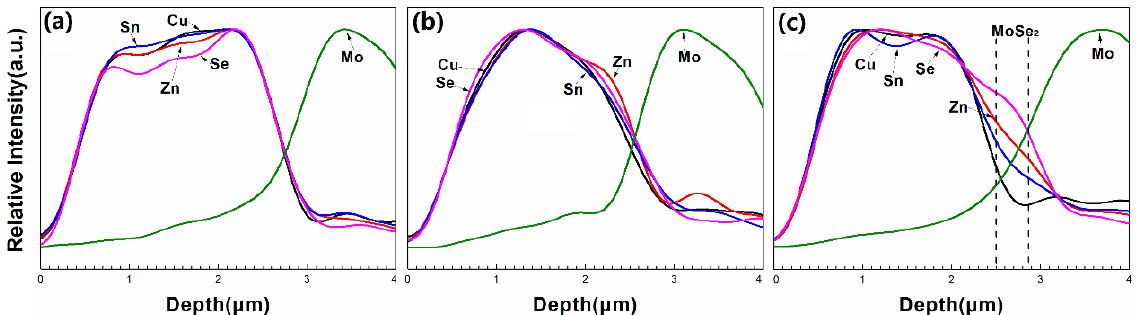
Figure 8. The line scanning energy dispersive spectroscopy (EDS) depth profiles of the CZTSe films that were prepared bythe selenization of the precursor with samples ( a ) A1; ( b ) A2; and ( c ) A3.